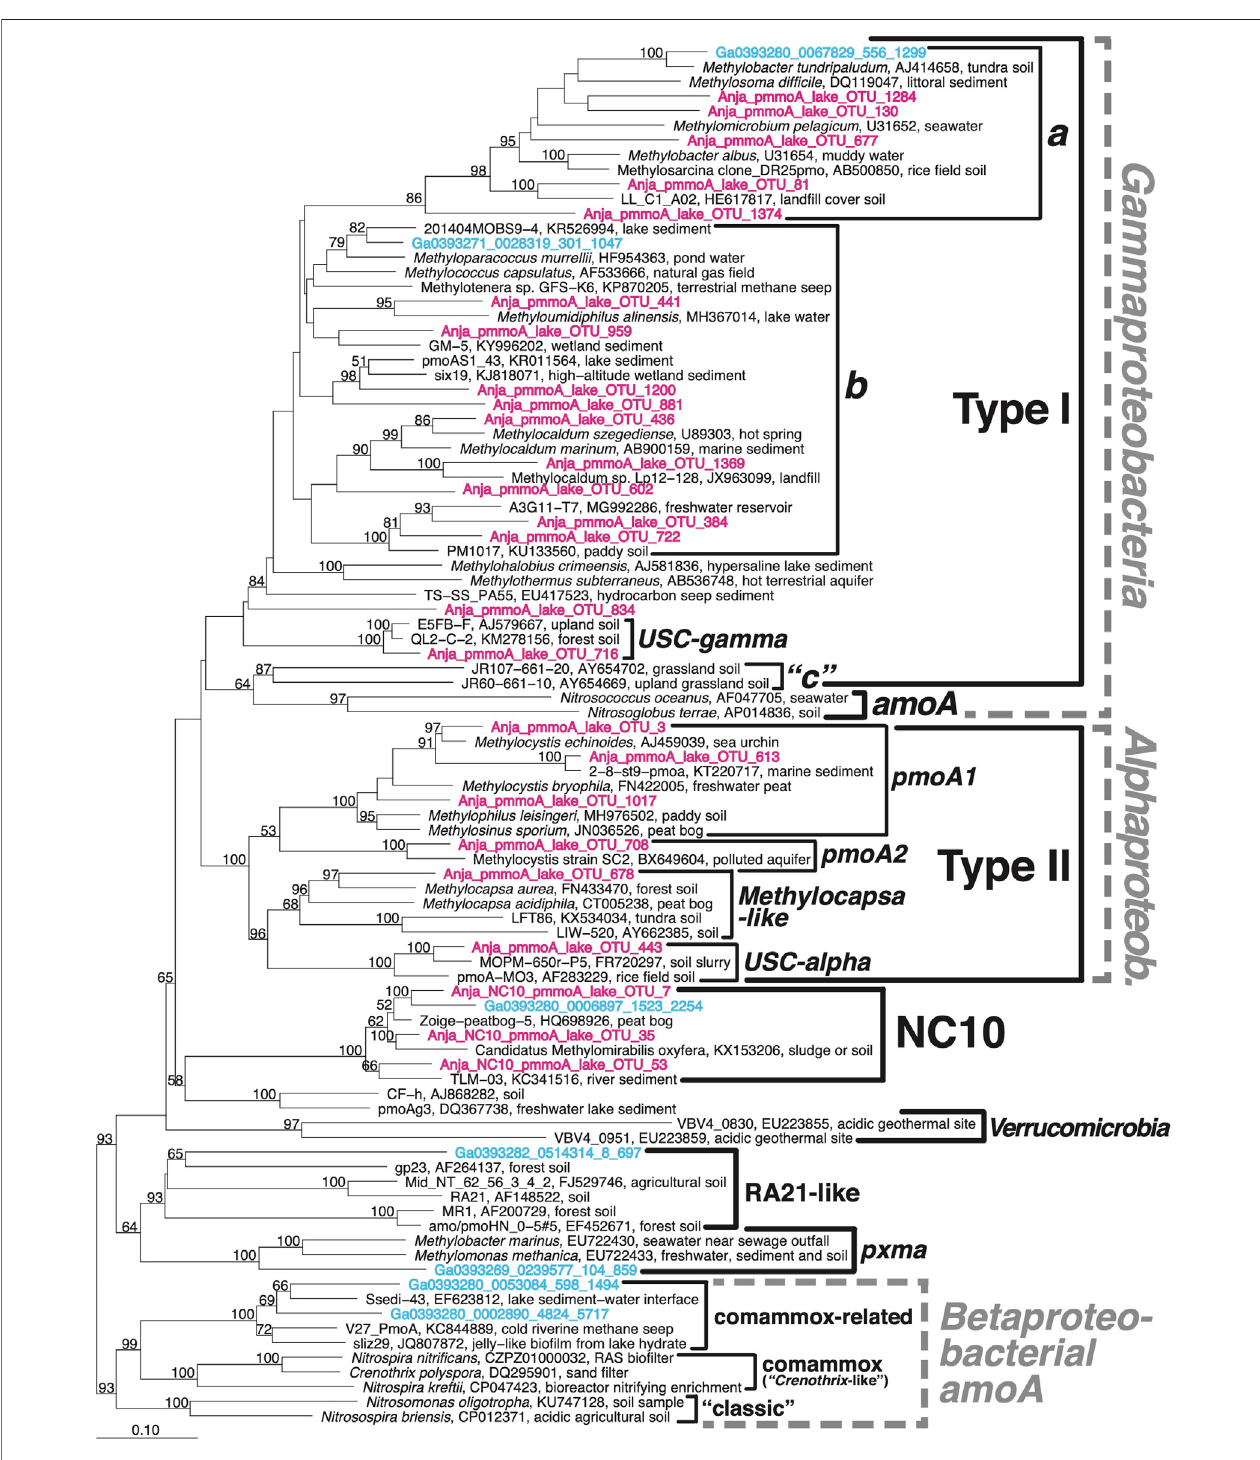
FIGURE 3 | Neighbour-joining phylogenetic tree of pmo A amplicon sequences obtained using the general A1809/Mb66a and NC10-speci fi c pmoA29F/590R primer combinations (pink) as well as metagenomic pmo A sequences (blue). The latter are only shown in cases where metagenomic analyses revealed the presence of pmo A (sub)clusters that were not detected by amplicon sequencing. Branching patterns with ≥ 50% bootstrap support (1,000 replicate calculations) are indicated at branch nodes.